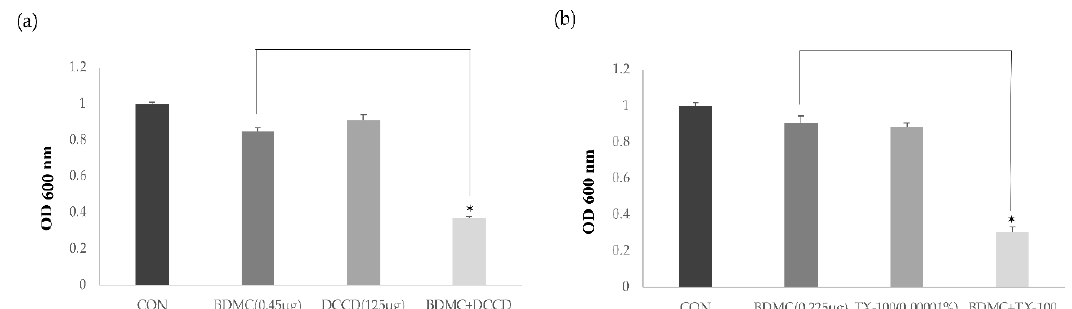
Figure 2. The effect of membrane-permeabilizing agents and ATPase inhibitors on the susceptibility of MRSA (ATCC 33591) to BDMC. Bacterial viability was determined by absorbance at 600 nm after incubation for 24 h with BDMC concentrations of 0.45 μg/mL BDMC in the presence of 125 μg DCCD ( a ) and 0.225 µg/mL BDMC in the presence of 0.00001% TX-100 ( b ). The data were presented as the mean ± standard deviation of the three independent experiments. * represents p < 0.05. CON, untreated control MRSA; DCCD, N,N’-dicyclohexylcarbodiimide; TX-100, Triton X-100; OD 600, optical density at 600 nm.